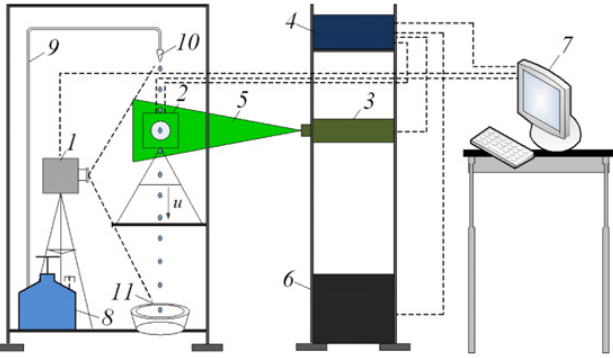
Figure 1. A schematic illustration of experimental setup: 1 – high-speed video camera; 2 – cross-correlation camera; 3 – double pulsed solid-state laser; 4 – synchronizer of personal computer (PC), cross-correlation camera and laser; 5 – light “pulse”; 6 – laser emission generator; 7 – PC; 8 – vessel with a water; 9 – water feed channel; 10 – doser; 11 – catcher. gas-vapor-liquid flows (“Particle Image Velocimetry” (PIV) [9] and “Interferometric Particle Imaging” (IPI)